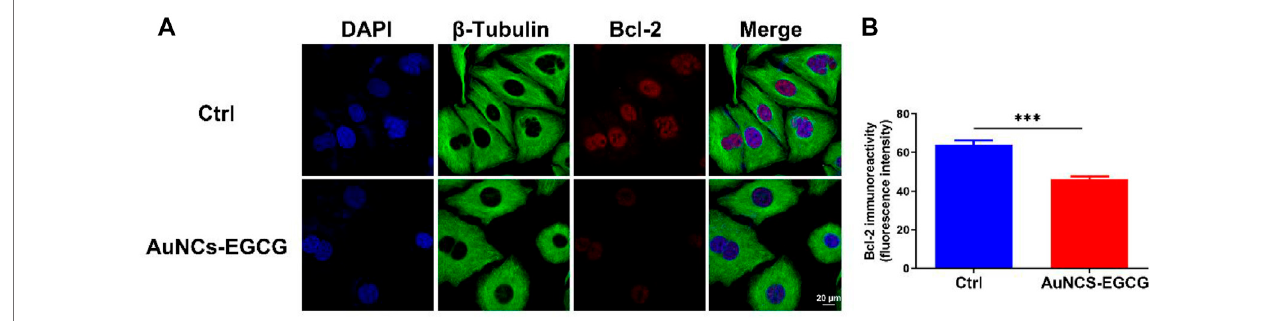
FIGURE7| NIR-responsiveAuNCs-EGCGinhibitedtheexpressionlevelofBcl-2proteininHepG2cells (A,B) .Confocalmicroscopyimmuno fl uorescenceanalysis of Bcl-2 protein expression and its semi-quanti fi cation analysis. Scale bars are 25 μ m. The mean and standard deviation (SD) of the data ( n = 3) are shown. Statistical analysis: ppp p <